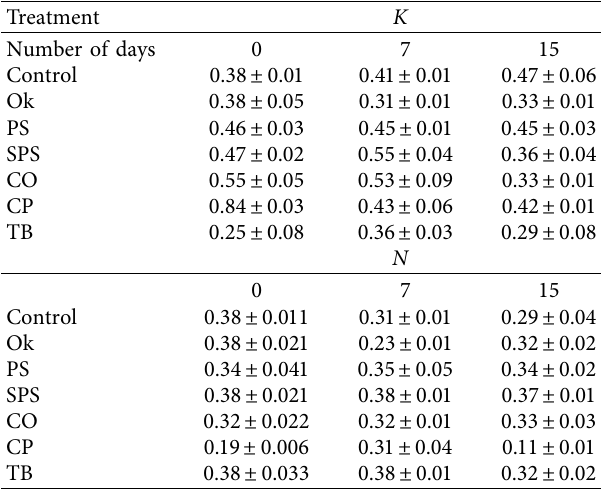
Table 1: The k and n of yogurt prepared with okra gum and different starches.